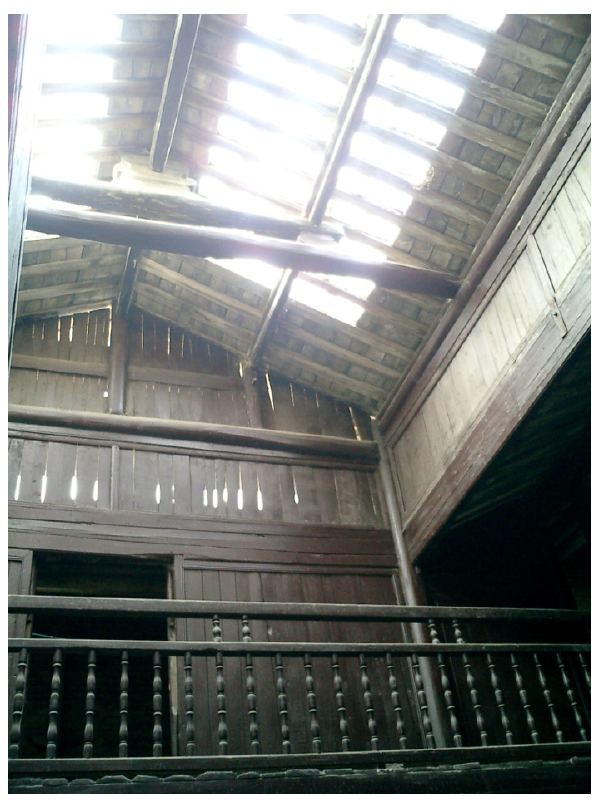
Figure 32. Roof lights photo [18].